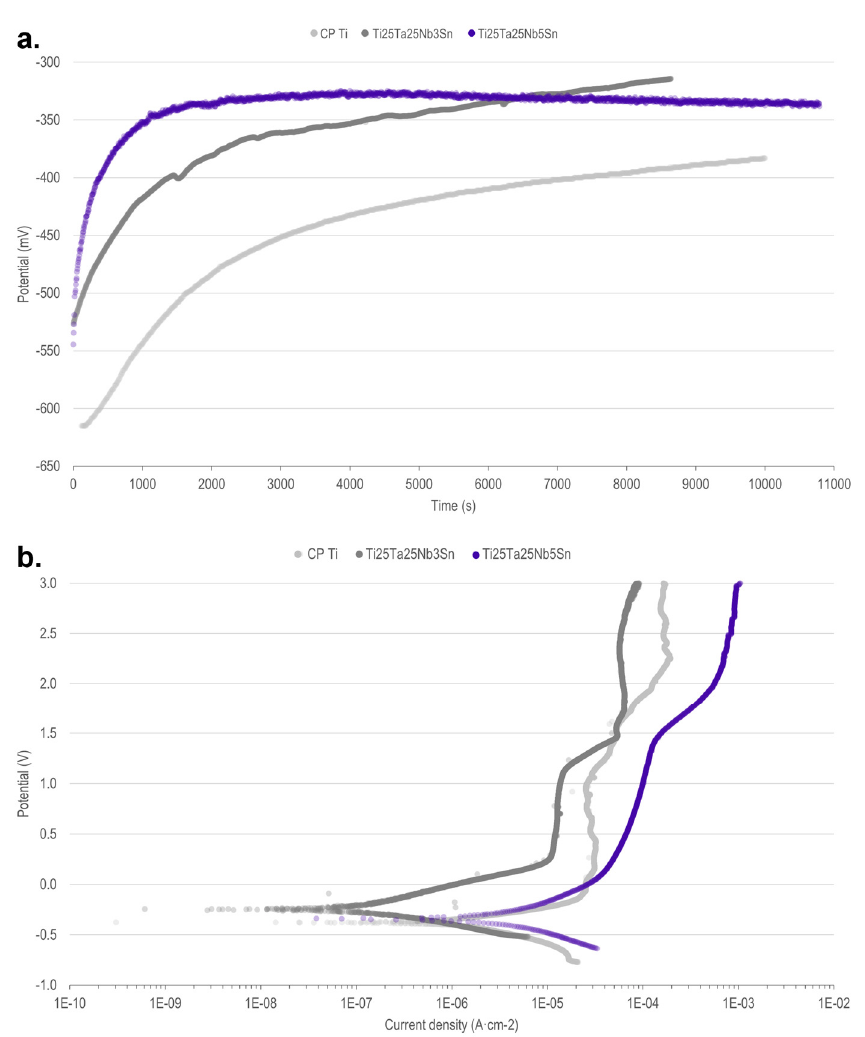
Figure 4. Corrosion tests of Ti-25Ta-25Nb-5Sn, Ti-25Ta-25Nb-3Sn, and CP Ti in fluoridated physio- ical serum (0.15 M NaCl + 0.03 M NaF (pH = 6.0)) at 37 ◦ C. ( a ) Open-circuit potential. ( b ) Potentiody- logical serum (0.15 M NaCl + 0.03 M NaF (pH = 6.0)) at 37 °C. ( a ) Open-circuit potential. ( b ) Poten- namic polarization tiodynamic polarization test.